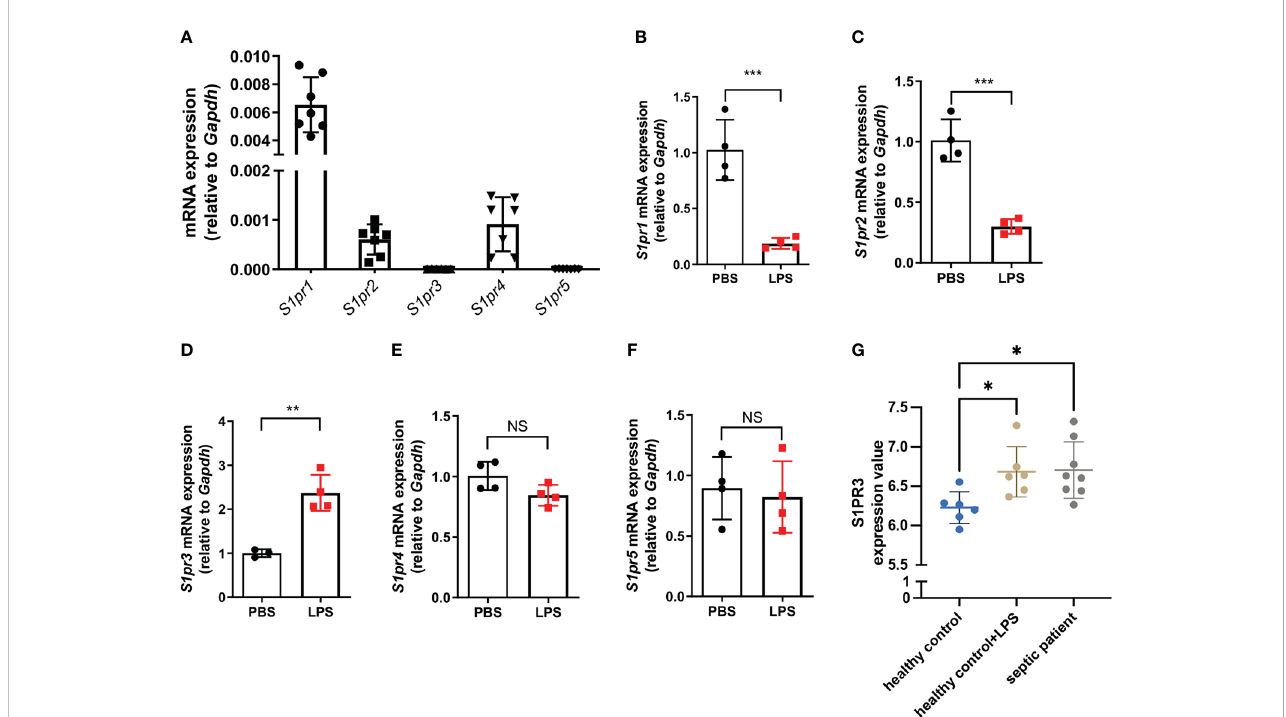
FIGURE 1 The expression of sphingosine-1-phosphate receptors in BMDMs. (A) Relative mRNA expression of S1PRs to GAPDH in BMDMs (n=7). (B-F) BMDMs were treated with LPS (1 m g/mL) or PBS for 4h. The mRNA expressions of S1PRs in BMDMs were measured by RT-qPCR (n=4). (G) The mRNA expression values of S1PR3 in monocytes from healthy controls stimulated with or without LPS, and from septic patients were analyzed with data from the GEO database. Data are presented as mean ± SD. *p<0.05, **p < 0.01, ***p < 0.001, two-tailed t-test. NS,